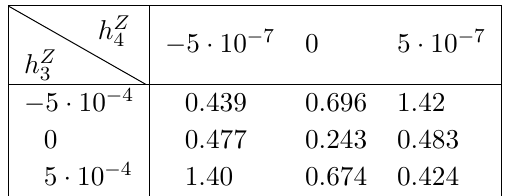
Table 7 . Cross sections [fb] for the exclusive Z ( (cid:23) (cid:22) (cid:23) ) (cid:13) process, requiring a photon